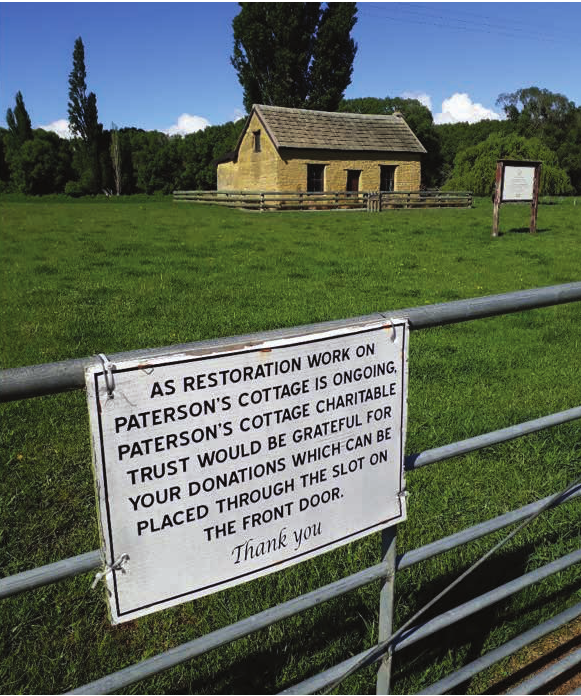
Figure 1: A restored and now protected late 19 th century rural cottage, South Canterbury, New Zealand. Image provided by Author (Mike Mackay)